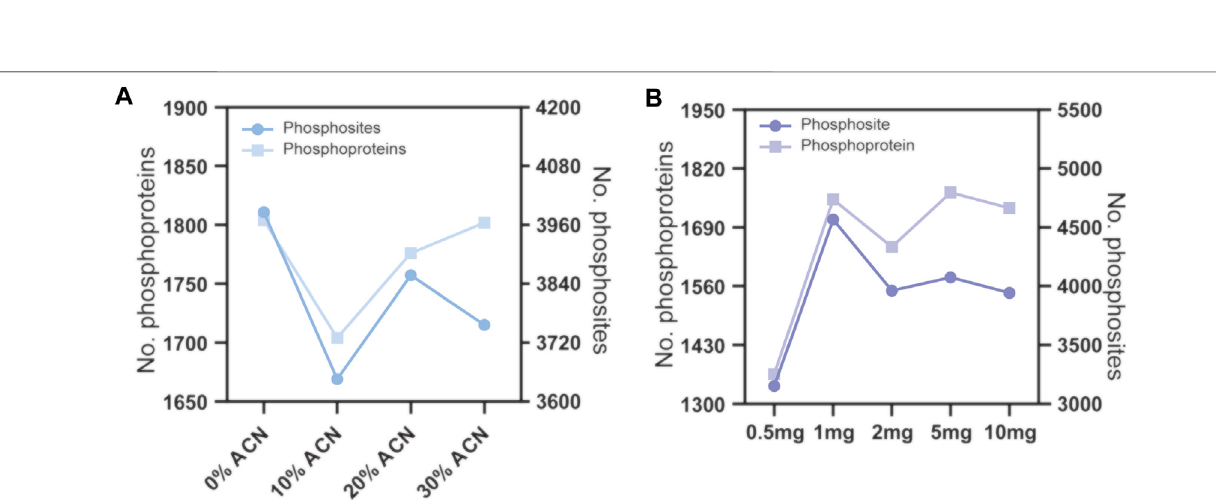
Frontiers in Molecular Biosciences |